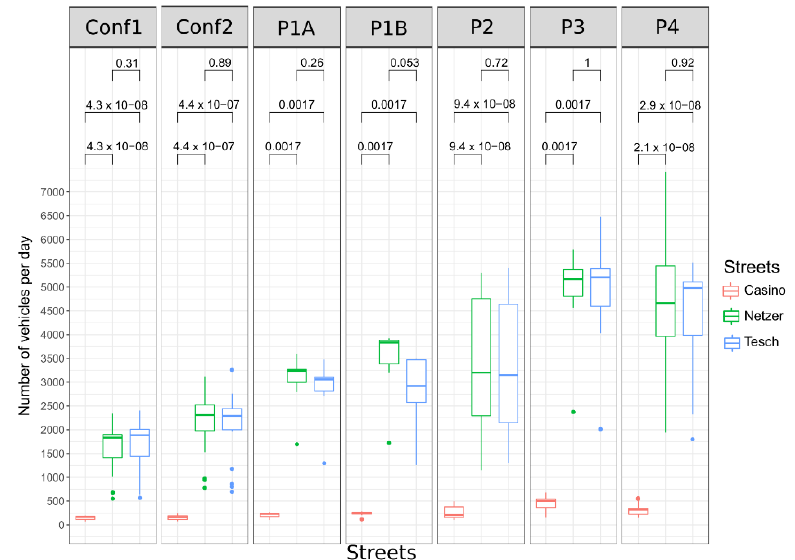
Figure 8. The sum of vehicles per day for each period. The p – values are the results of a Mann – Whitney Wilcoxon pairwise test with the Holm correction ( α threshold = 0.05).